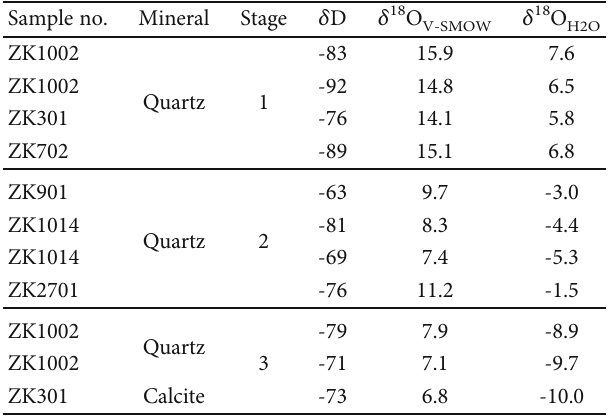
Table 5: Sulfur isotope compositions of pyrite from the Longmendian Ag-Pb-Zn